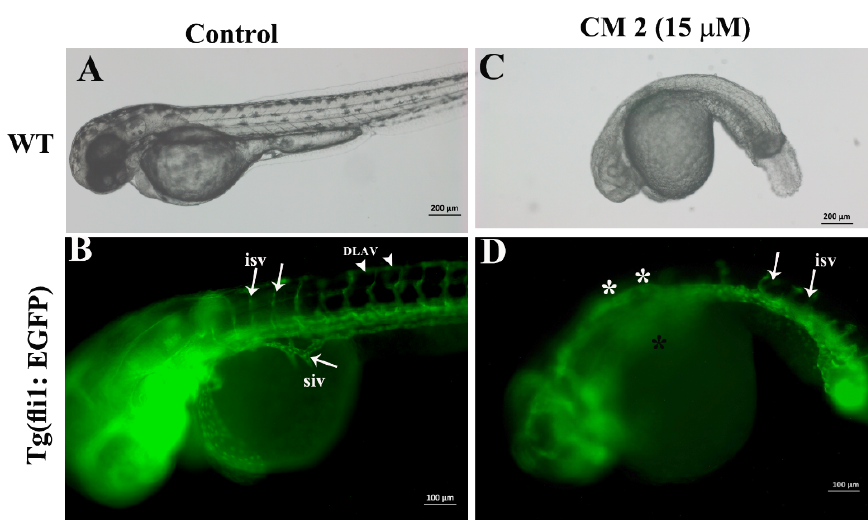
Figure 6. 2-acetoxyfuranodiene decreased the formation of angiogenic blood vessels during zebrafish embryonic development. ( A ) Bright field image of a Tg (fli1: EGFP) embryo that was exposed to 0.1% methanol as a control. The embryos developed normally. ( B ) The fluorescent image of a Tg (fli1: EGFP) embryo at 72 hpf. The green color indicates all the blood vessels. The white arrows show the inter-segmental blood vessels in the trunk of the control embryo, which were the first angiogenic blood vessels that formed at around 48 hpf. The emergence of the second angiogenic blood vessels can be seen on the trunk of the control embryo. ( C ) A Tg (fli1: EGFP) embryo treated with 15 µM of CM2. The bright field images show that CM2 at 15 µM affected the normal development of zebrafish embryos. The embryos were much smaller in size, the body was curved, and there was no pigmentation. ( D ) The CM2 treatment disrupted the inter-somatic blood vessel formation in the treated zebrafish embryos, the majority of the inter-somatic blood vessels did not form (white asterisks), and some blood vessels formed but they did not grow and failed to connect to dorsal longitudinal anastomotic vessel. Similarly, the sub-intestinal vein did not form in the transgenic zebrafish embryos that were treated with CM2.